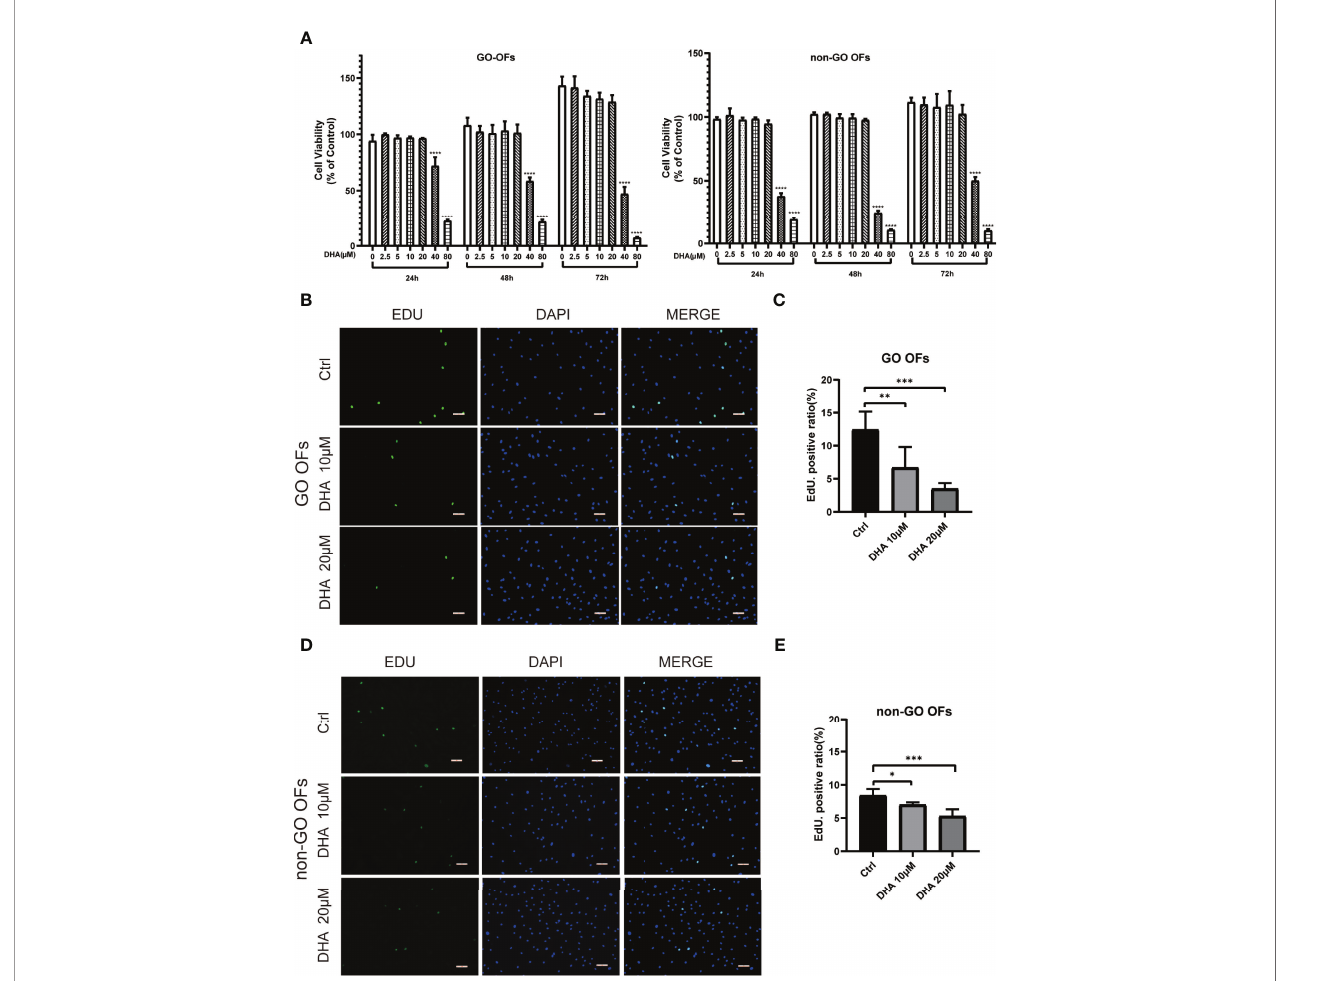
FIGURE 1 | Effect of DHA on the cellular viability of OFs from GO and non-GO patients. (A) OFs obtained from 3 GO patients and 3 non-GO patients were treated with increasing concentrations of DHA (0, 2.5, 5, 10, 20, 40, and 80 m M) for 24, 48, and 72 h, respectively. Cell viability is presented as the percentage relative to the viability of the untreated cells. (B, D) Representative images of the EdU assay results in GO OFs and non-GO OFs treated with different concentrations of DHA (10, 20 m M). The cells were observedusing a fl uorescence microscope, scale bars= 50 m m.Green: EdU, Blue: 4 ′ ,6-diamidino-2-phenylindole(DAPI). (C,E) Quanti fi cation of the EdUassay results of GO OFsand non-GO OFs(Ctrl, DHA [10, 20 m M], n = 5). For (A,C) , and (E) , the summarizeddata are reported as the mean ± standard errorofthe mean.*P < 0.05, **P < 0.01, ***P < 0.001, **** P < 0.0001, versus the Ctrl